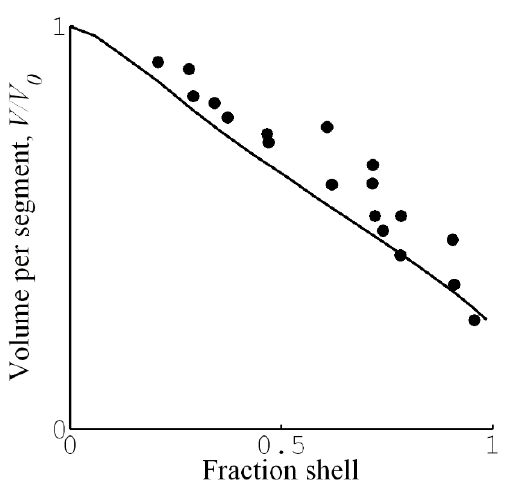
Figure 12. Normalized volume of core per network charge plotted vs. fraction of network in shell for core–shell gels. V 0 is the volume per charge in the surfactant-free gel. Symbols: Experimental data for the system PA gel–C 16 TACl [21]. Line: Theoretical model calculation by G&H [74]. Figure taken from ref. [74]. Reprinted with the permission of AIP